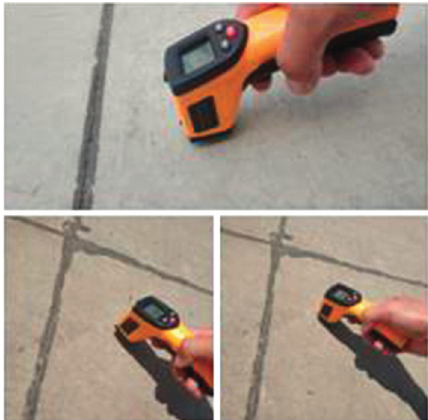
Figure 2: On-site daily measurement of pavement surface temperature.